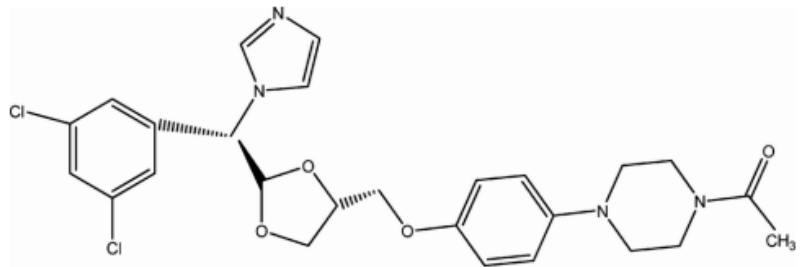
Figure 1. Chemical structure of ketoconazole.